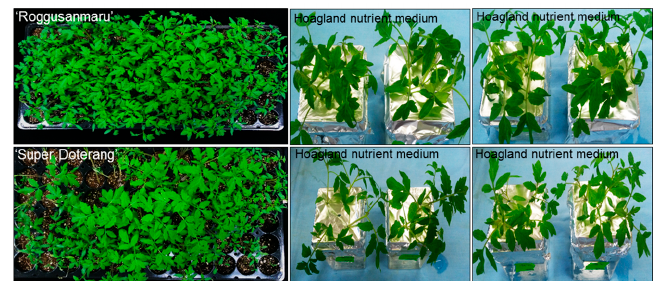
Figure 1. Representative images of tomato cultivars “Roggusanmaru” and “Super Doterang” used in the study.